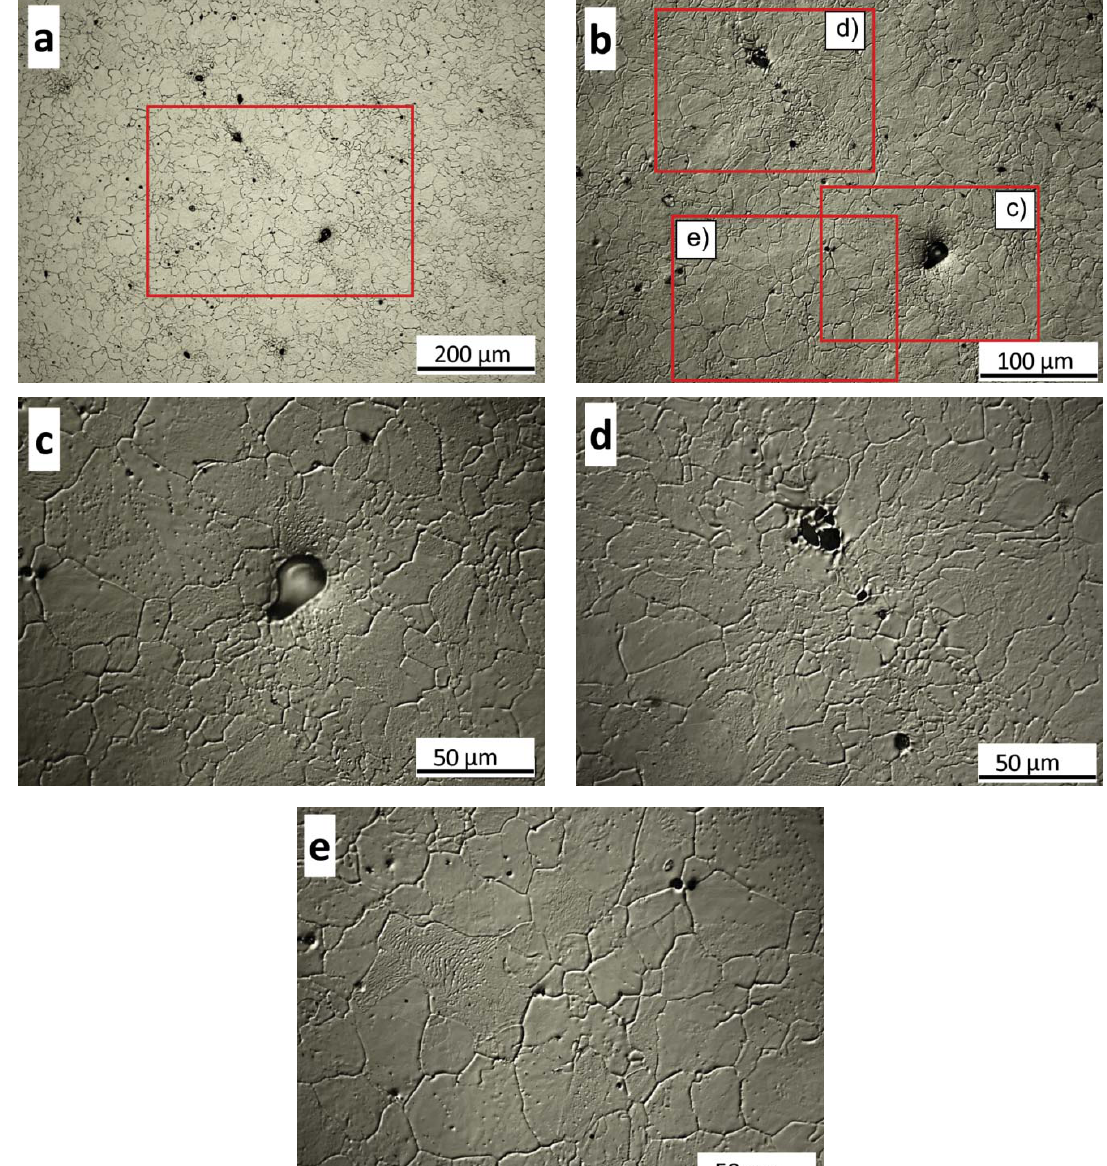
Figure 5. LOM micrographs of the prior austenite grain boundaries revealed by thermal etching. ( a ) Bright field image of the microstructure at a low magnification; ( b ) Micrograph corresponding to the red-square in image ( a ), using Nomarski microscopy (DIC); ( c , d ) images of interdendritic zones (richer in solute) where non-metallic inclusions and microshrinkage are present and smaller grains can be observed. ( e ) Image of a dendritic zone (poorer in solute) showing bigger grains.